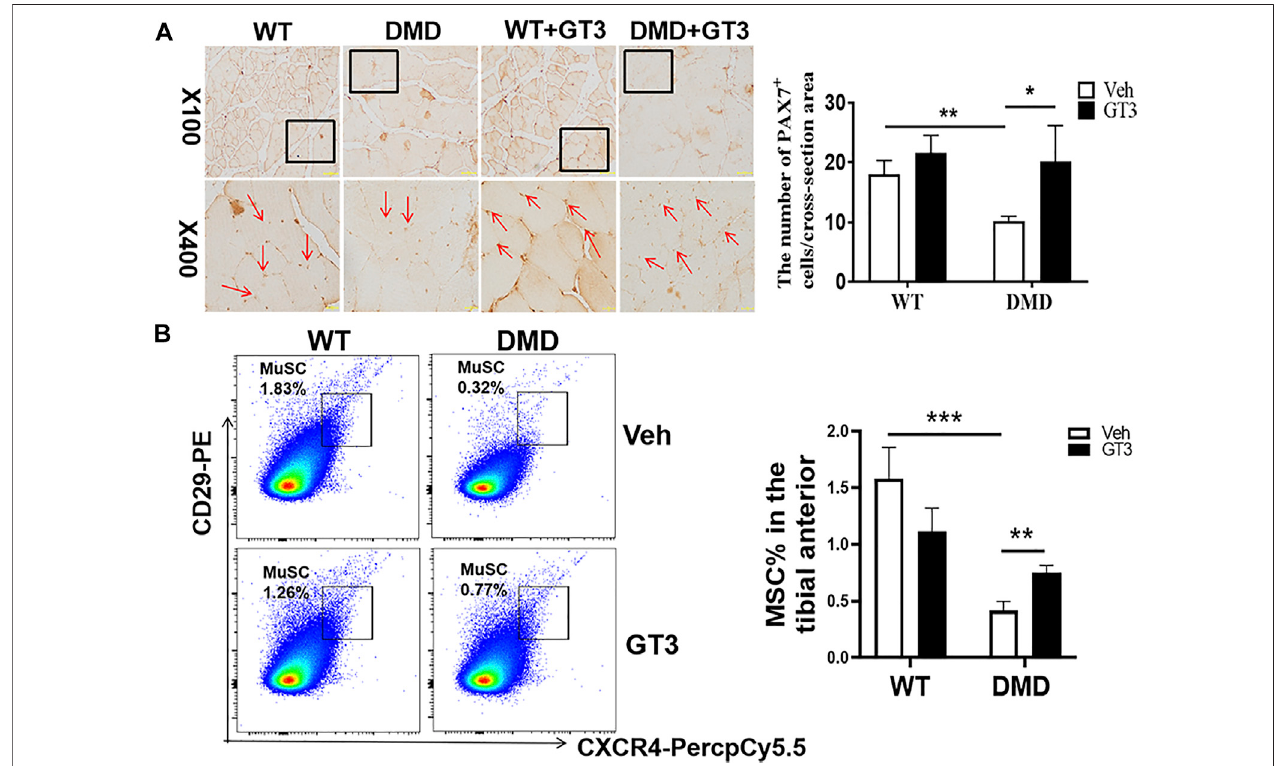
FIGURE 7 | Changes in the numbers of muscle stem cells after GT3 treatment. (A) Forty-week-old WT and DMD mice were treated with GT3 for 48 h. The tibialis anterior were taken for PAX7 immunostaining (red arrow). Numbers of PAX7 positive cells were counted. * p < 0.05, ** p < 0.01. (B) CXCR4 and CD29 fl ow cytometry antibody were used to label muscle stem cells (left panel). The percentages of CD11b − CD45 − CD29 + CXCR4 + cells were demonstrated in the right panel. ** p < 0.01, *** p < 0.001.